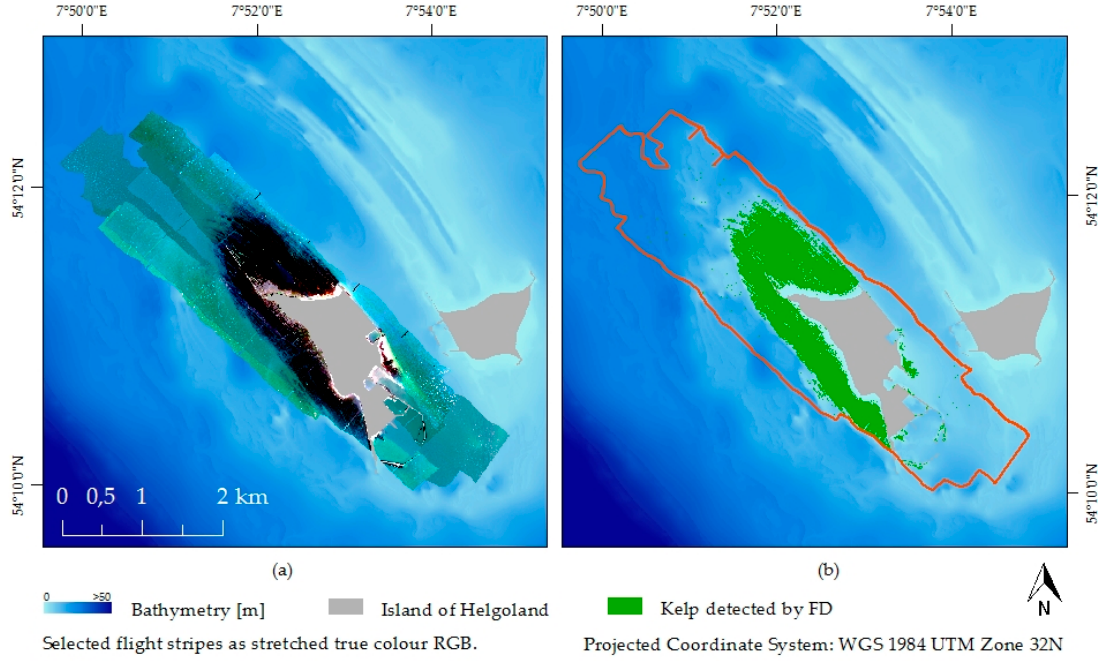
Figure 6. ( a ) Stretched true colour image of selected flight stripes and ( b ) kelp detected by FD. Table 3. Validation of the FD kelp detection results with dive transect mappings per flight stripe (FS).